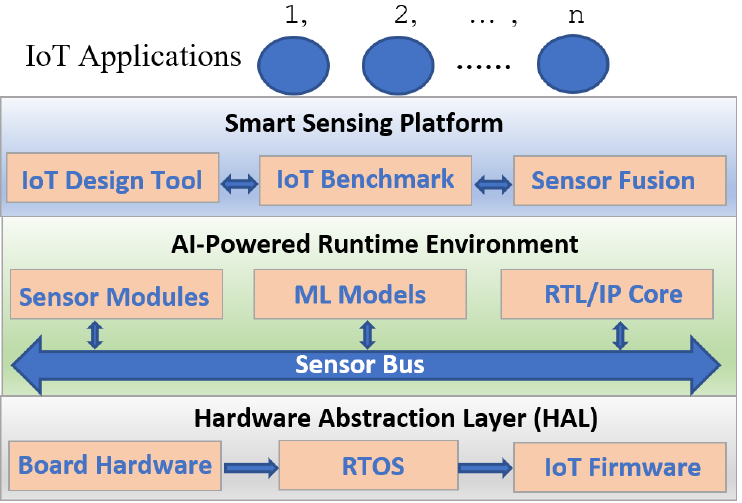
Figure 4. The proposed AI-power platform for smart